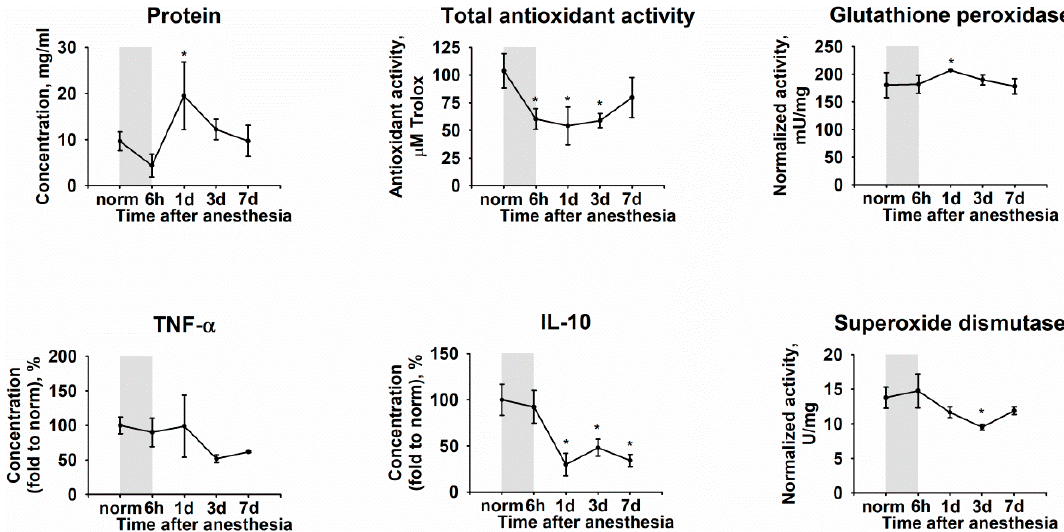
Figure 3. Dynamic changes in biochemical properties of TF in DES. The animals were exposed to general anesthesia for 6 h (shown as gray box). TF samples were collected before (norm) and immediately after (6 h) the general anesthesia as well as on 1, 3, and 7 day post-exposure. The samples were analyzed for total protein, TNF- α , IL-10, as well as total antioxidant activity (in Trolox equivalent) and activity of glutathione peroxidase and superoxide dismutase using the respective assays. * p < 0.05 as compared to parameters of TF of the intact (control) animals.